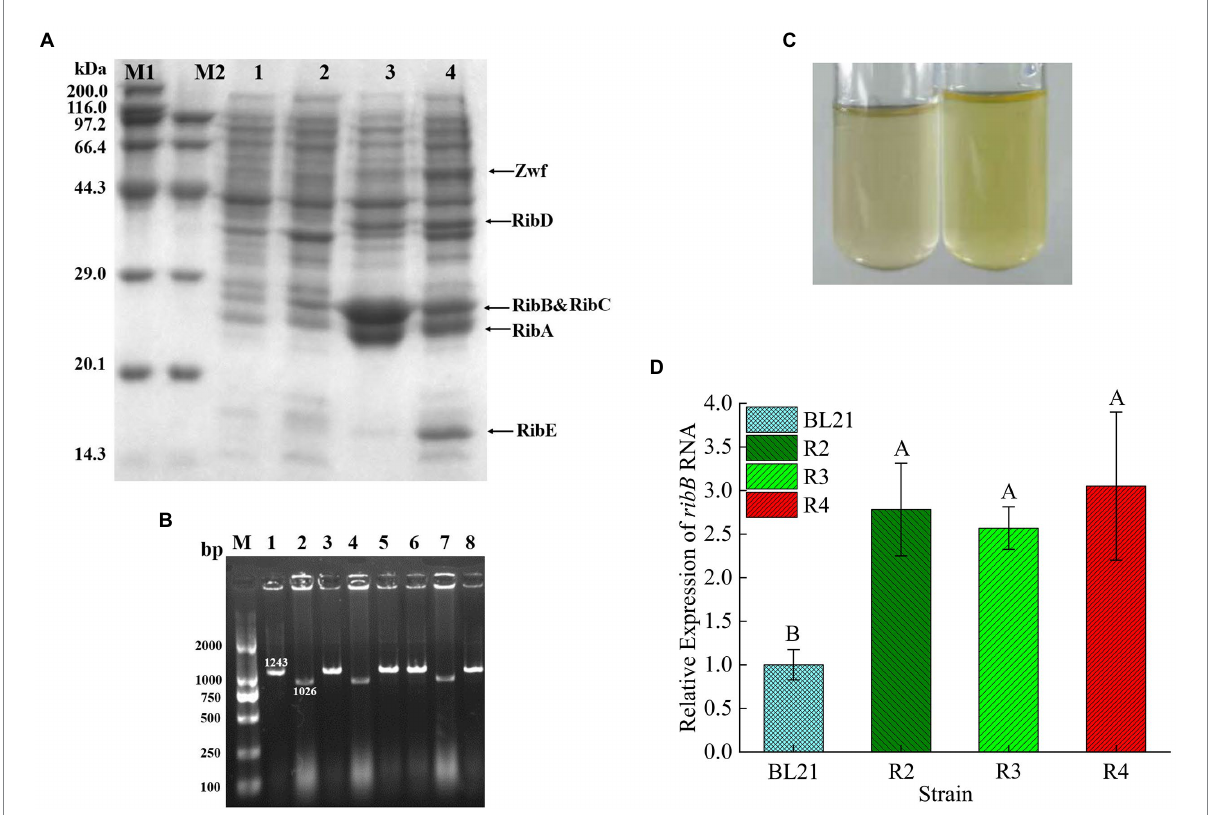
FIGURE 4 (A) SDS-PAGE analysis of the recombinant E. coli . Lane M: protein molecular weight marker; Lane 1: precipitated proteins from E. coli BL21/ pETDuet-1&pACYCDuet-1 after IPTG induction; Lane 2: proteins in supernatant from E. coli BL21/pETDuet-1&pACYCDuet-1 after IPTG induction; Lane 3: precipitated proteins from strain R2 after IPTG induction; Lane 4: proteins in supernatant from strain R2 after IPTG induction. (B) Colony PCR analysis of E. coli BL21 ▵ sroG . The length of the positive band was 1,026 bp, while the negative band was 1,243 bp. (C) Comparison of the supernatant color after E. coli was incubated overnight in 5 ml of LB medium (left: E. coli BL21; right: R3). (D) Comparison of ribB transcript levels of different strains by qPCR. p < 0.01. Letters indicate significant differences.